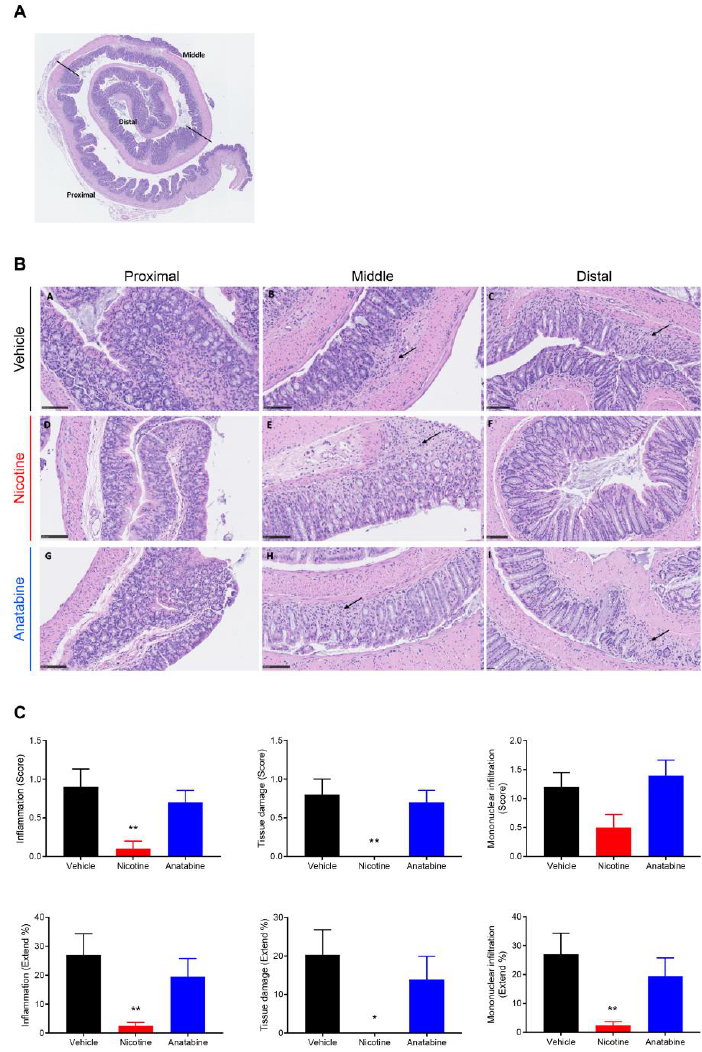
Figure 3. Nicotine reduces histological features of UC at D7. ( A ) Representative HE Swiss-roll colon staining showing the selected proximal, middle, and distal parts. ( B ) Representative HE colon staining showing representative inflammatory foci (arrow) for the three parts of the colon (B-A, B-D, B-G = proximal, B-B, B-E, B-H = middle, and B-C, B-F, B-I = distal) in the three groups (B-A, B-B, B-C = vehicle, B-D, B-E, B-F = nicotine, and B-G, B-H, B-I = anatabine). Scale bar = 100 µ m. ( C ) Inflammation (left panels), tissue damage (middle panels), and mononuclear cell infiltration (right panel) score (upper panels) and extent (lower panels) in the distal colon. Mice were sacrificed at the end of DSS administration (D7) for histology assessment. Mean ± SEM are shown. * p ≤ 0.05, ** p ≤ 0.01. n = 10 for all